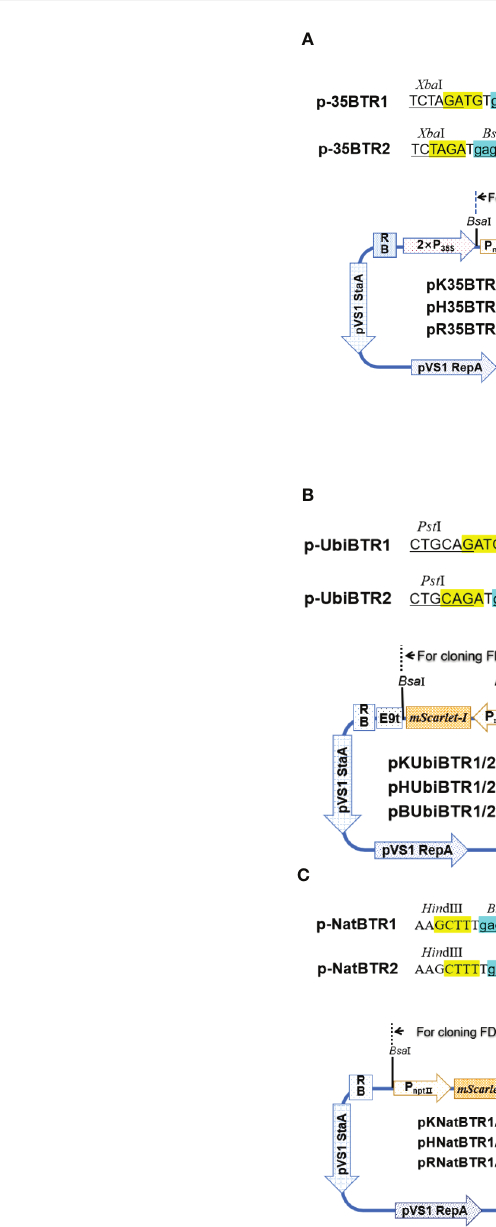
promoter analysis (Figure 2), and subcellular localization (Figure 3), based on the Golden Gate cloning method with only one restriction endonuclease Bsa I (the cheapest type IIs restriction endonuclease) and T4 ligase required. For each vector type, we developed two sets, termed pBTR1 and pBTR2,